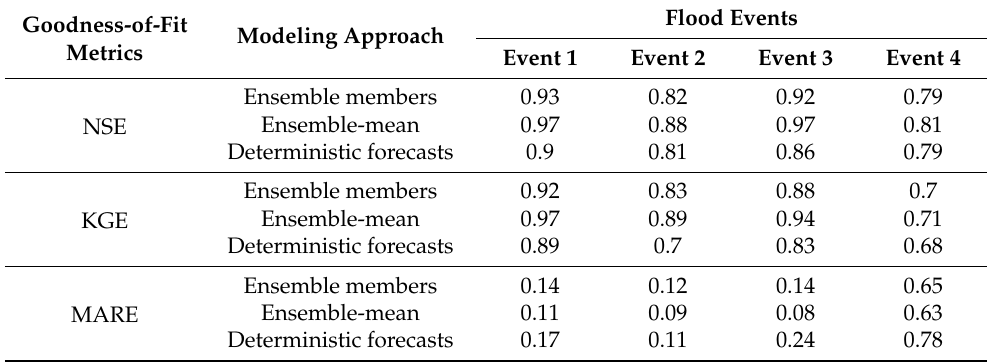
Table 11. The goodness-of-fit metrics used for the HBV model to simulate ensemble reservoir inflow in the calibration